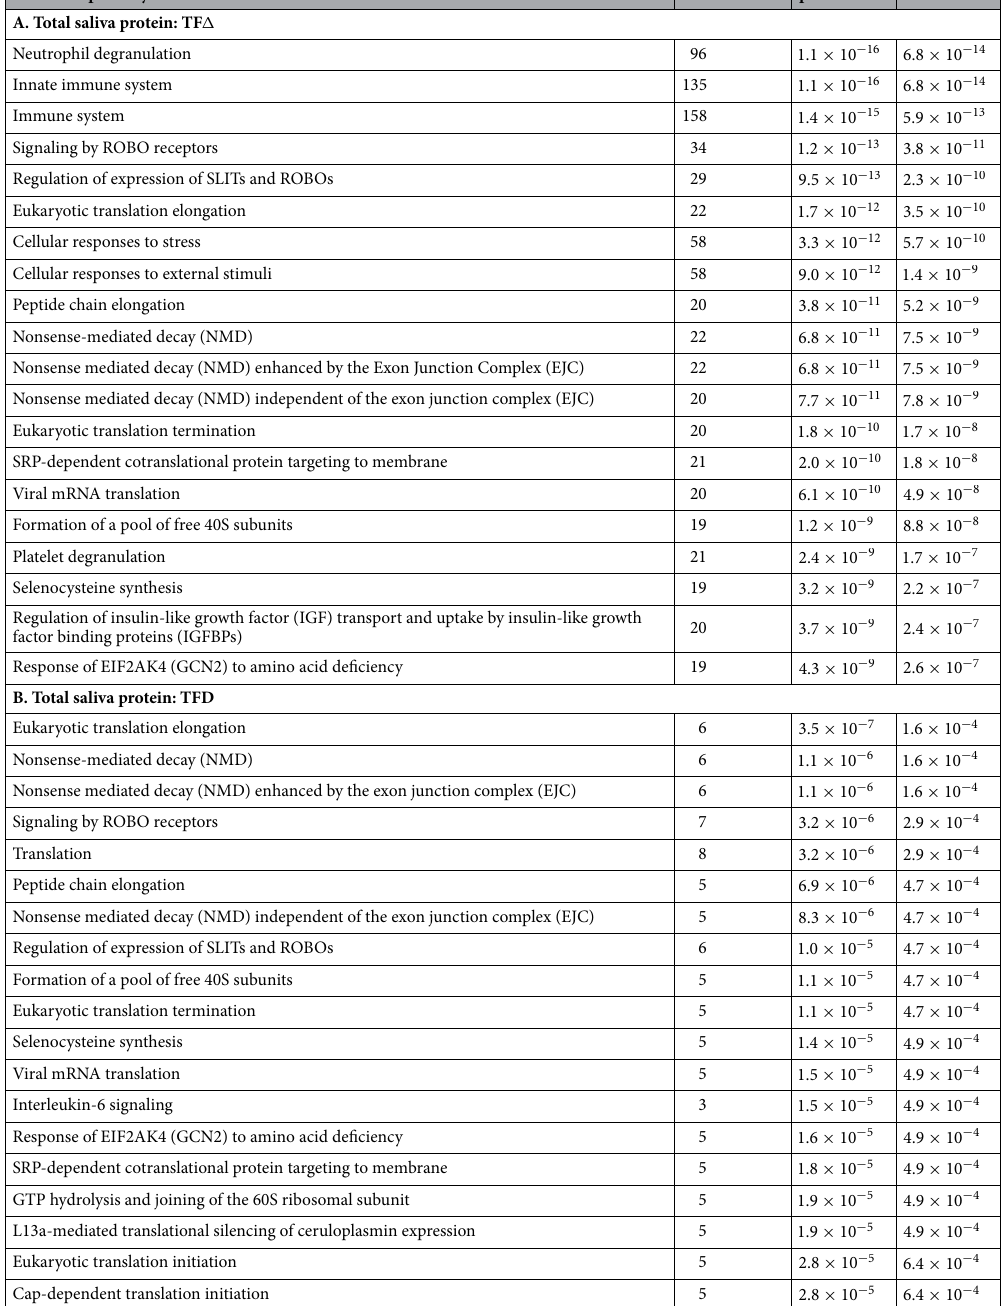
Table 3. Reactome pathway enrichment analysis results for protein Lag 1 aggregate results for TF (cid:31) and TFD (top 20 pathways based on FDR for each time frame